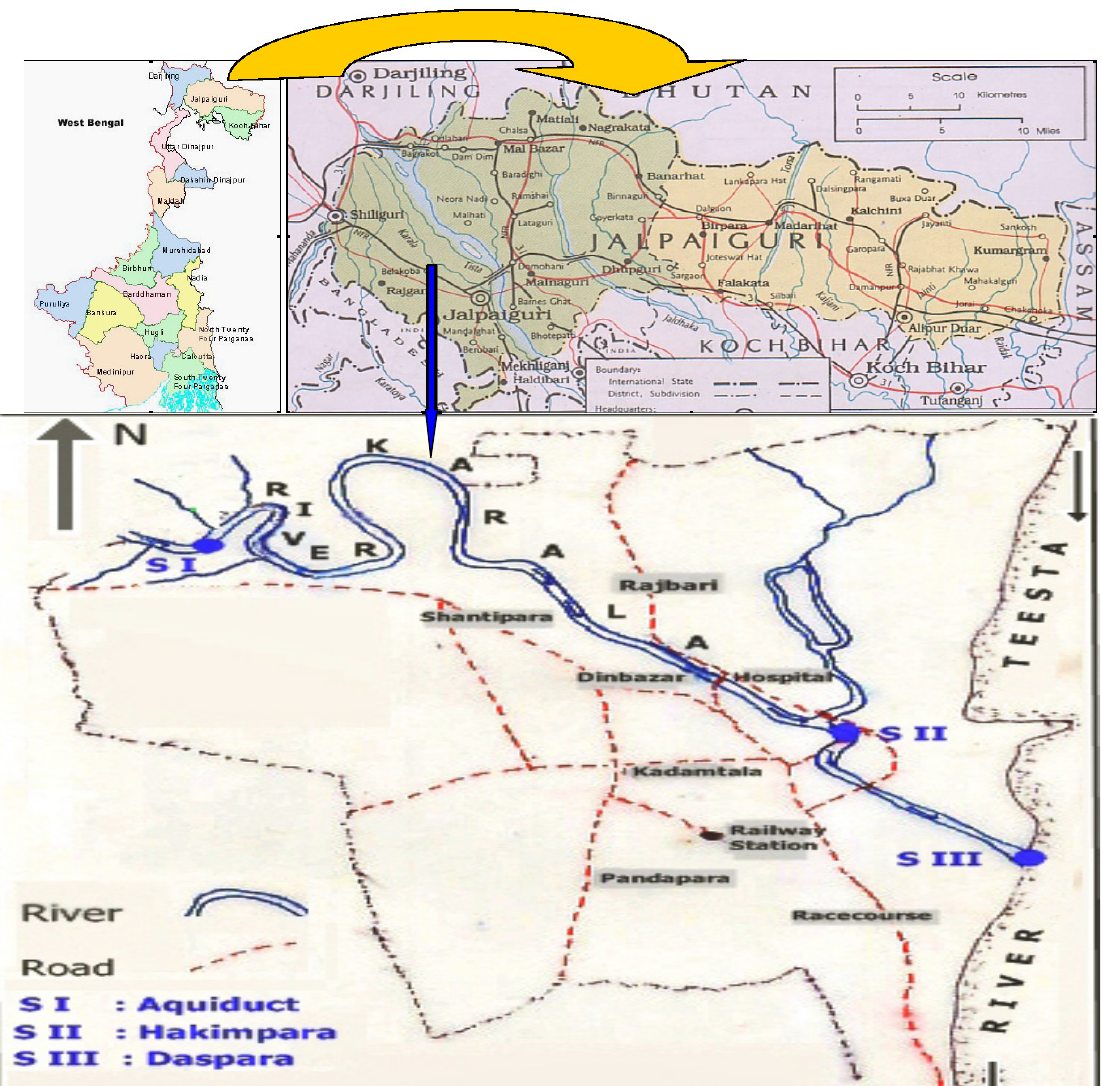
Figure 1. Origin and distribution of Karala River with three different study